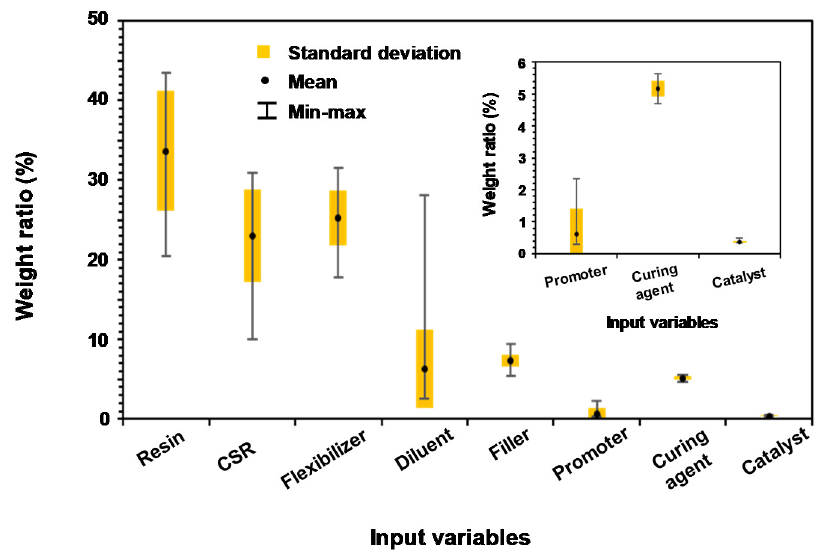
Figure 2. Statistical analysis of the minimum, maximum, and average values (with standard deviation) of the input variables in the data